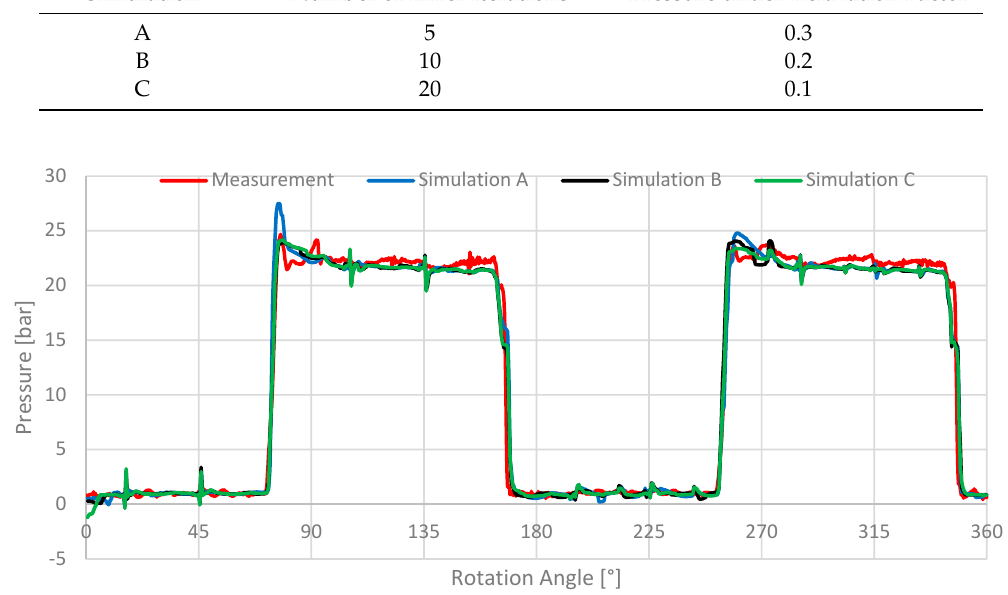
Figure 12. Influence of different numbers of inner iterations.